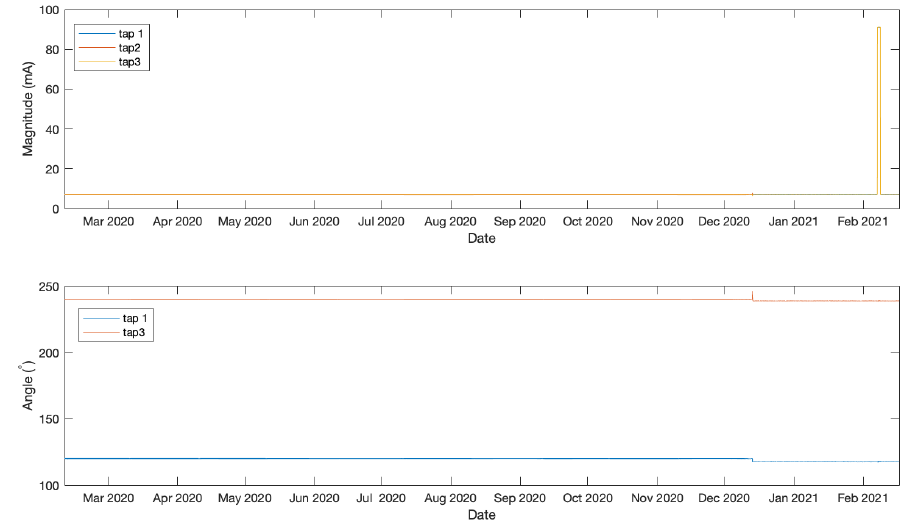
Figure 5. Angle and magnitude